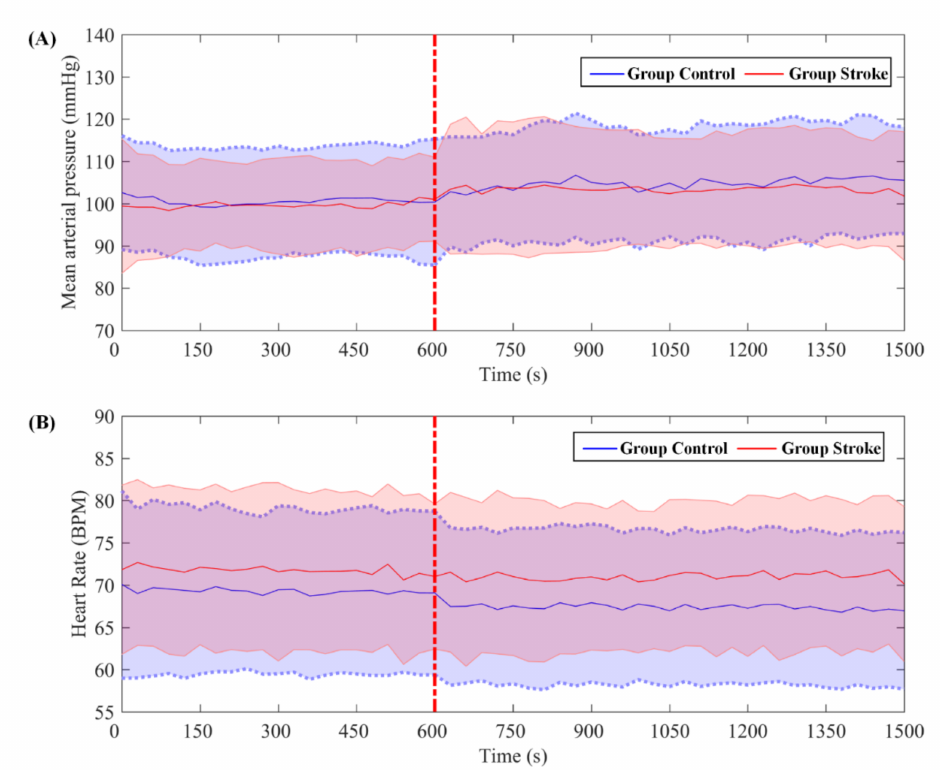
Figure 3. Group-averaged changes measured at State_R and State_ISPC in ( A ) mean arterial pres- sure and ( B ) heart rate, respectively. The red dotted line marks the start of the ISPC intervention. The middle solid line represents the mean of the signal, and the shaded area shows 95% confidence